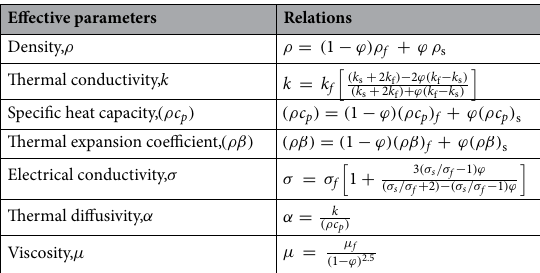
Table 3. Correlations for the properties (effective) of Cu-water nanofluid 4 .